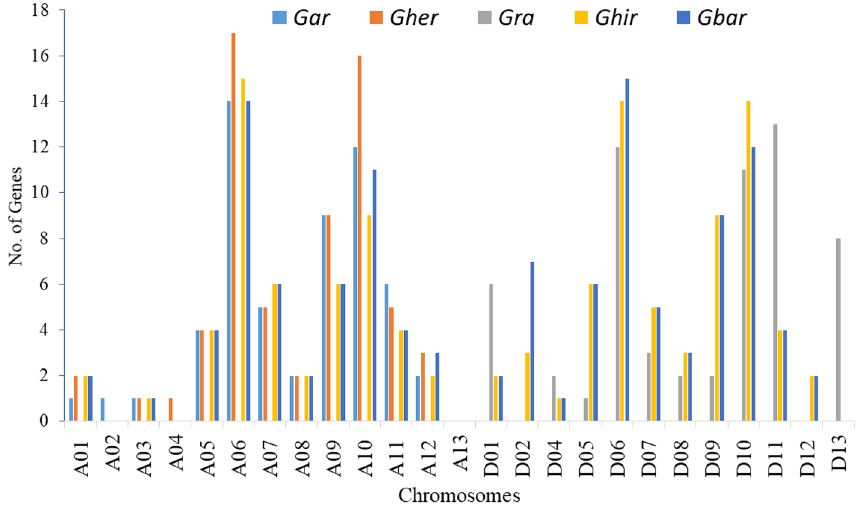
Figure 1. Gene density on A-like and D-like genomes of Gossypium sp